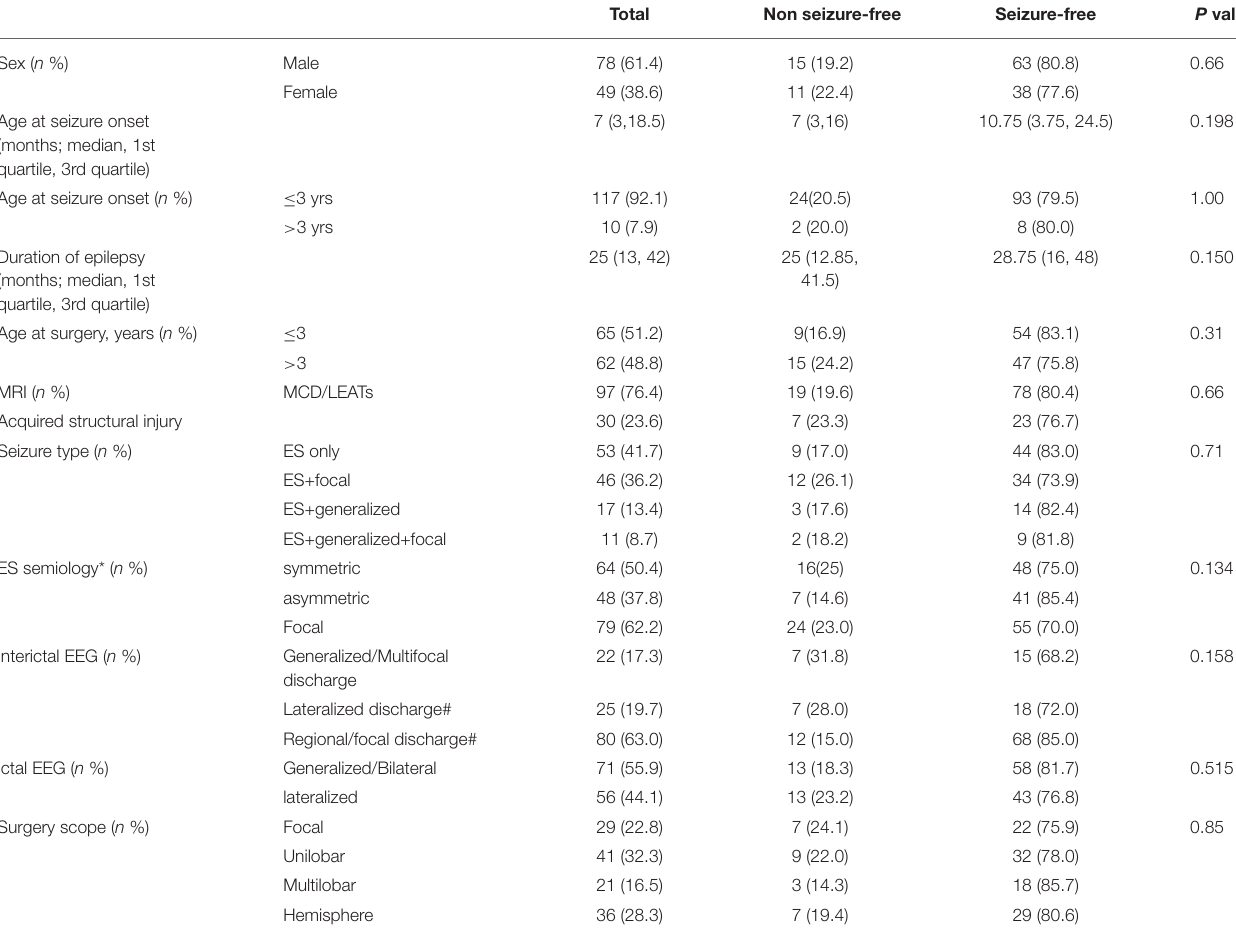
TABLE 2 | The relationship between electroclinical features of ES and postoperative seizure outcome ( n = 127).